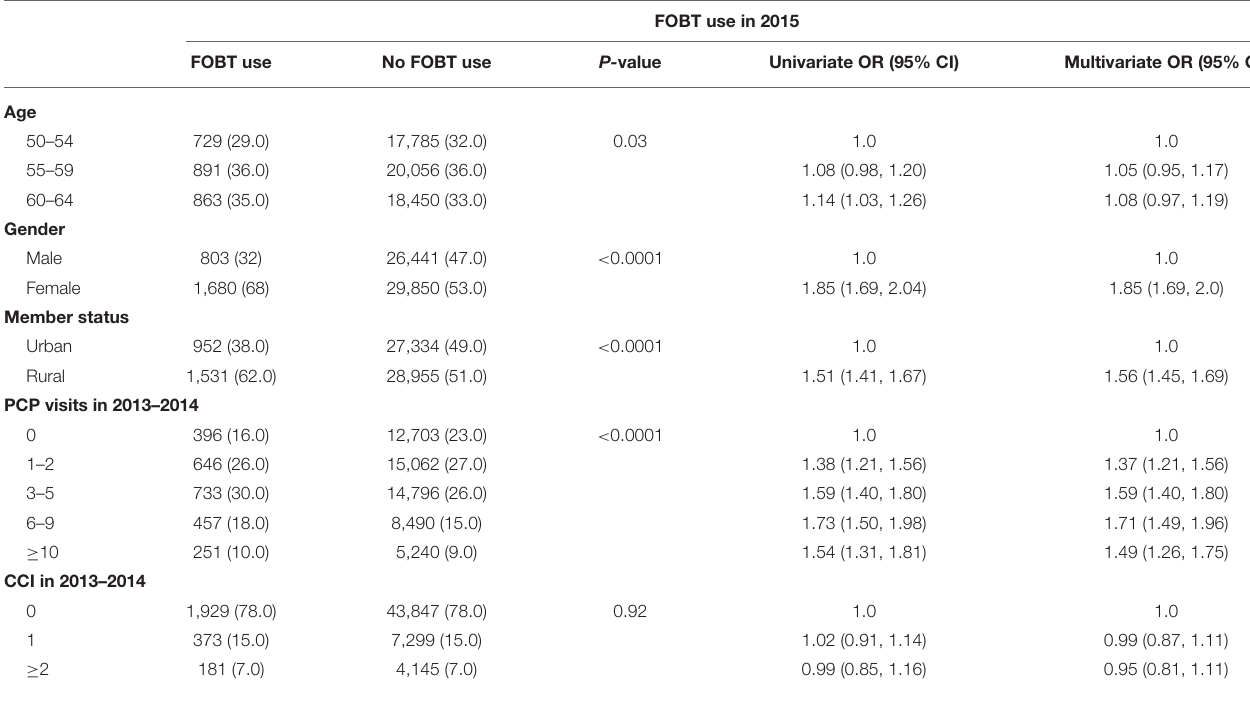
TABLE 2 | Univariate and multivariate analyses of variables associated with FOBT screening using logistic regression models, BCBSNE 2013–2015.